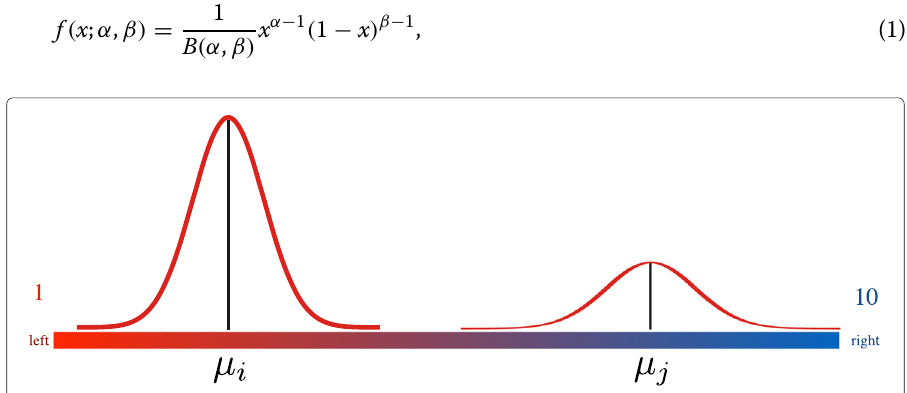
Fig. 2 Normal distribution modeling the ideology of political parties. Political parties have an ideology position located anywhere within the ideology spectrum. Parties’ ideologies are normally distributed ( N (μ , σ) ) around the mean μ with party ideology dispersion represented by the standard deviation